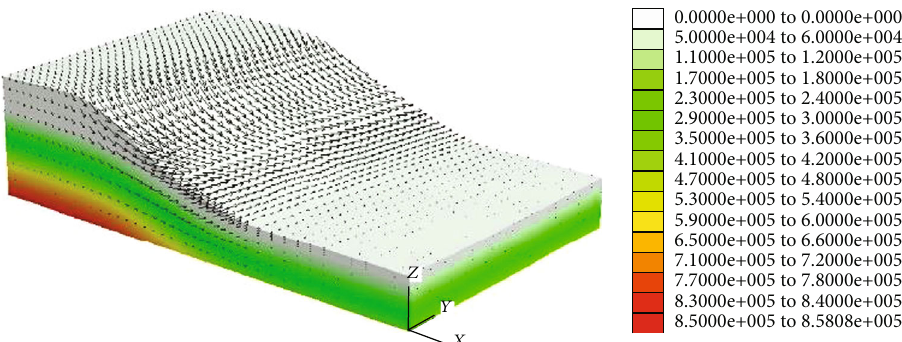
Figure 12: Pore-water pressure and displacement vector of slope in h = 37 m and b = 0 : 5 .